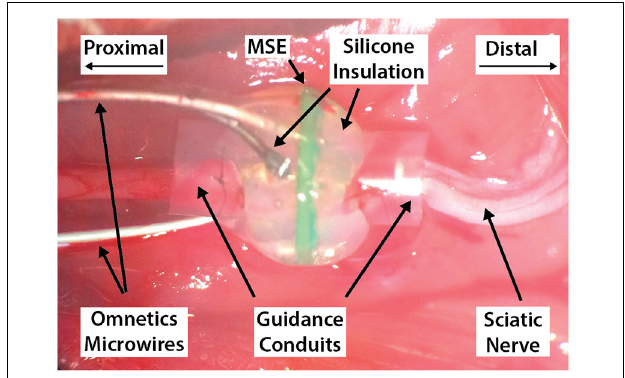
FIGURE 5 | An implanted macro-sieve electrode, with proximal and distal nerve stumps sutured into their respective guidance conduits. The Omnetics connector and its trailing microwires have been routed dorsally through a subcutaneous tunnel and out through a sagittal scalp incision exposing the